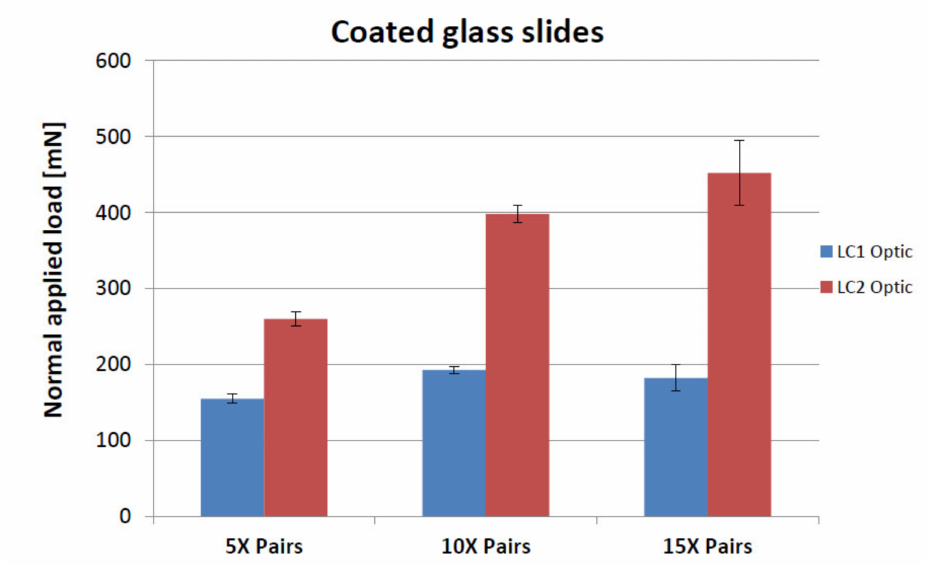
Figure 4. Comparative graph illustrating scratch resistance for the 5, 10 and 15 pairs of thin layers. LC1 is where the first cracks start to appear on the surface test track and LC2 is where there is complete failure of the coating. The 15 × bi-layered coating statistically withstood the greater load before complete failure; statistically there was no difference in the load for when the first crack appeared between the 10 × and 15 × bi-layered